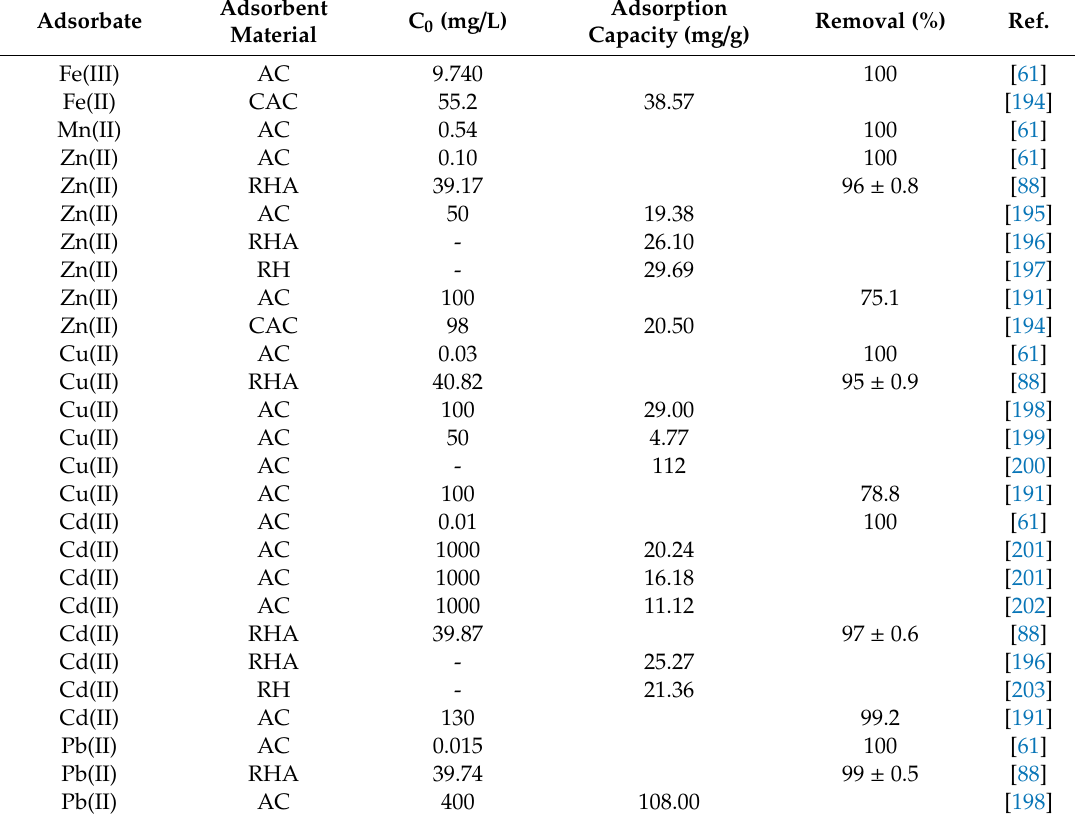
Table 8. E ffi cacy of CAC, RHA, and RH-derived AC for the removal of heavy metals